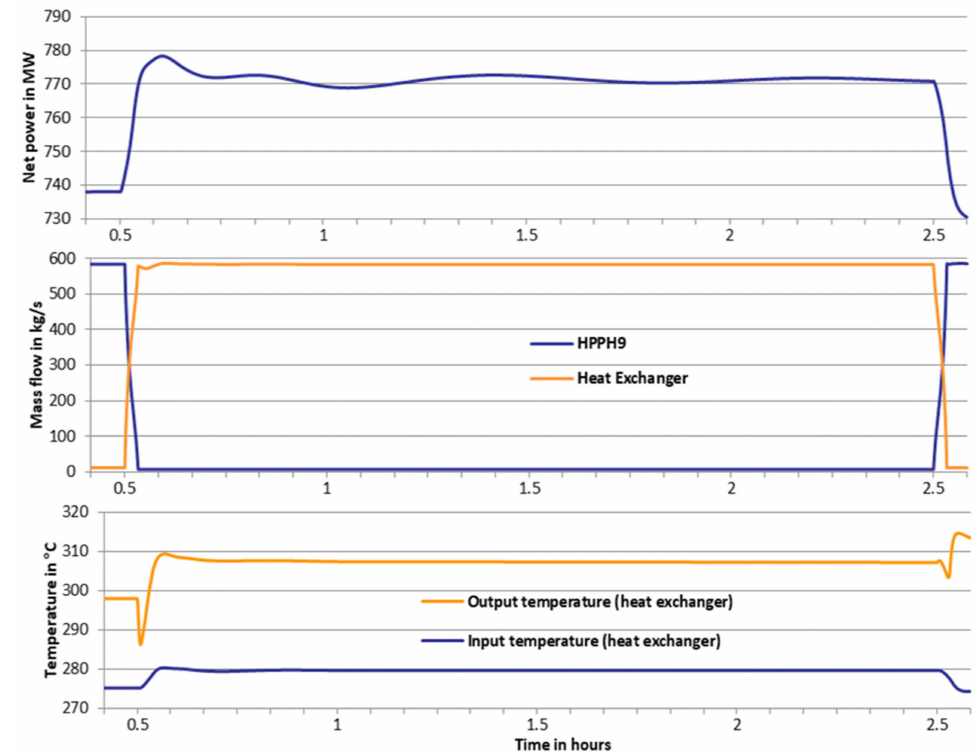
Figure 5. Curves of important process variables during the first discharge process (concept HRH-